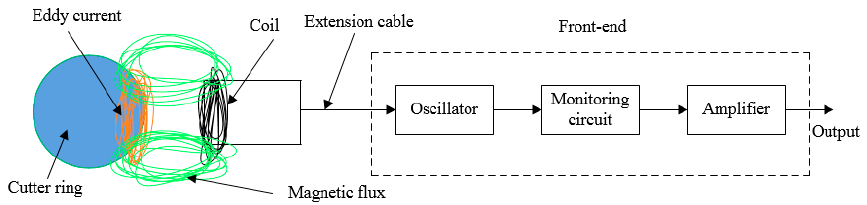
Figure 1. Eddy current sensor structure.